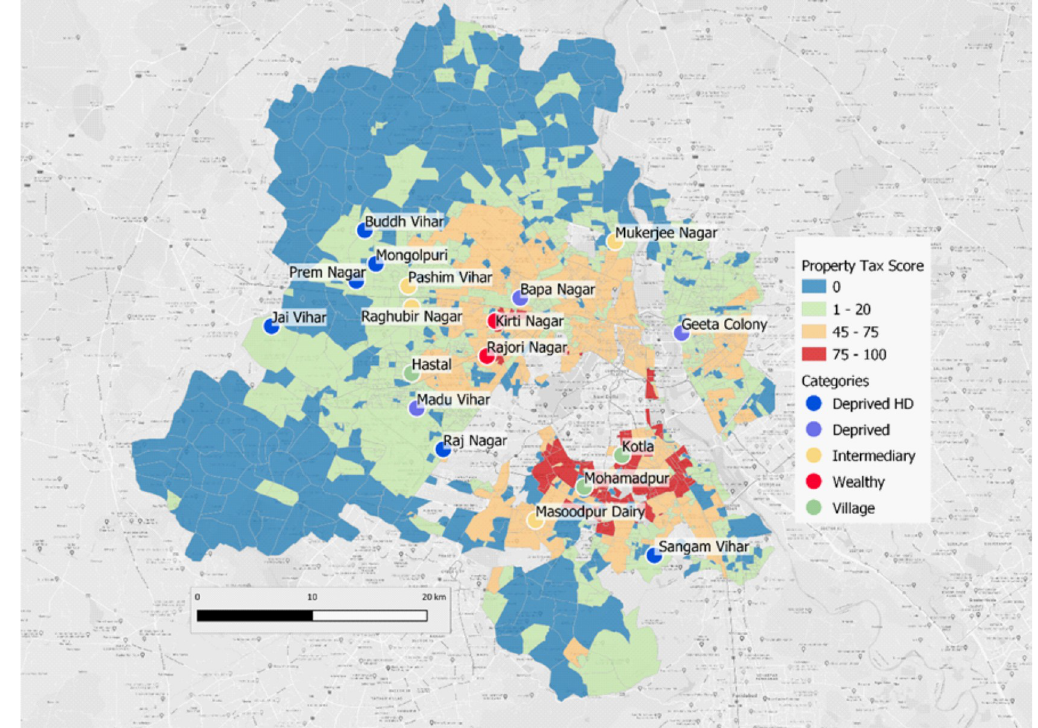
Fig 1. Map of 18 selected study sites within